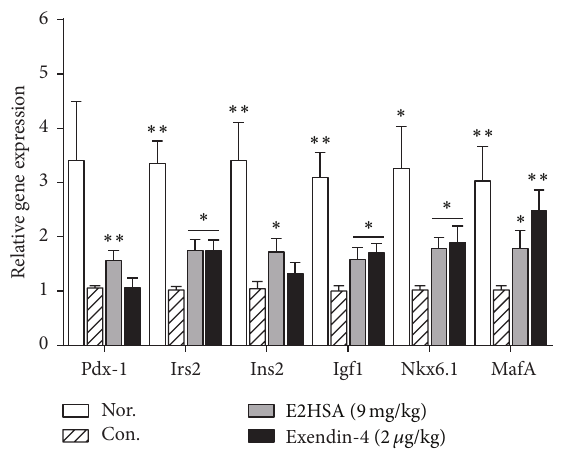
Figure 8: Expression of genes related to 𝛽 -cell function and survival in spontaneous type 2 diabetes db/db mice treated with E2HSA. Datawerefrompancreastailsamples.Geneexpressionwasanalyzed by quantitative real-time PCR. A comparative cycle threshold (CT) method was used for relative quantification of gene expression between different groups using 𝛽 -actin for normalization. Data are expressed as mean ± S.E.M ( 𝑛 = 4 - 5 ). ∗ 𝑃 < 0.05 and ∗∗ 𝑃 < 0.01 versus